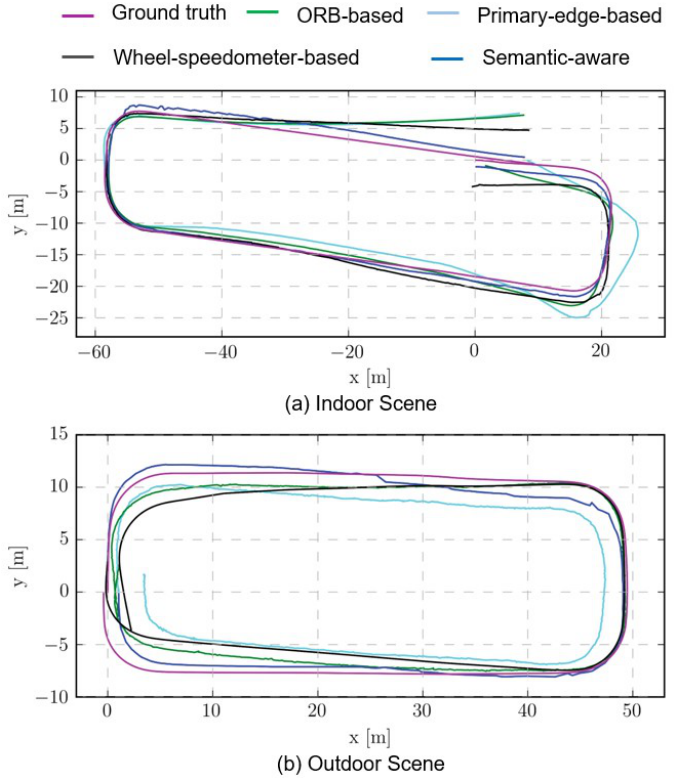
Figure 8. The comparisons of the trajectory estimation for different methods. ( a ) Indoor Scene, ( b ) Outdoor